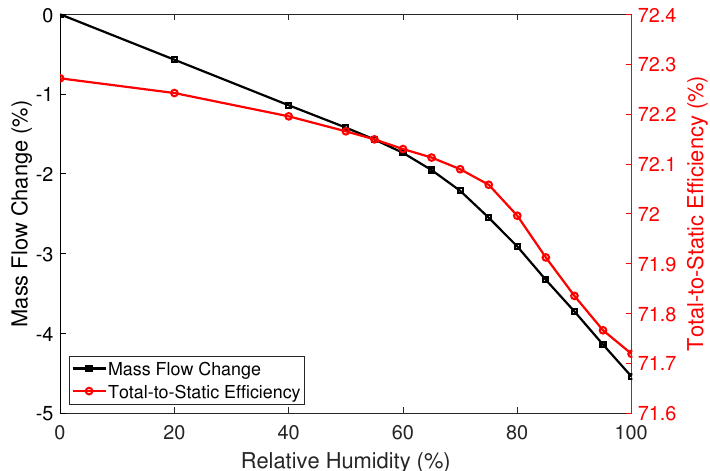
Figure 8. Total-to-static pressure ratio and efficiency in dependence of the relative humidity. Data taken from [12].